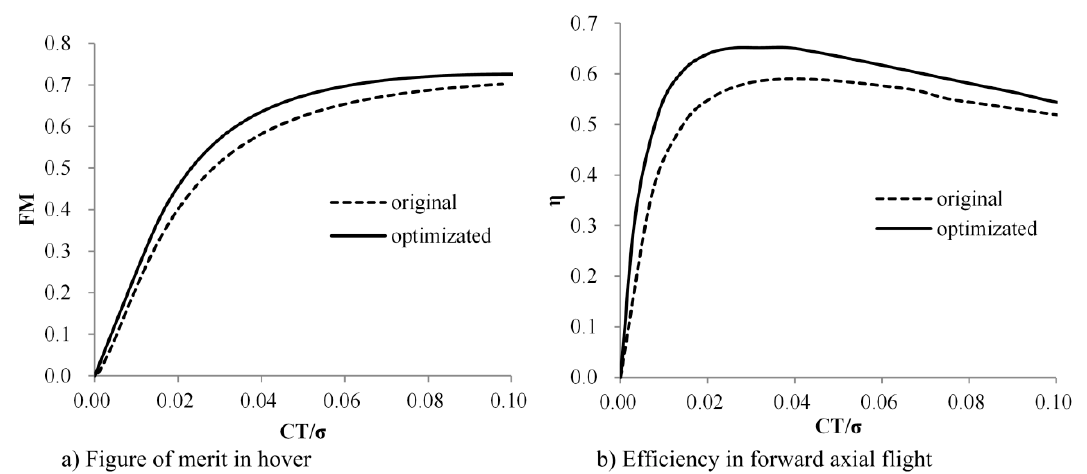
Figure 16. Global performance comparison of the original and optimized MTR in hovering and cruising states.